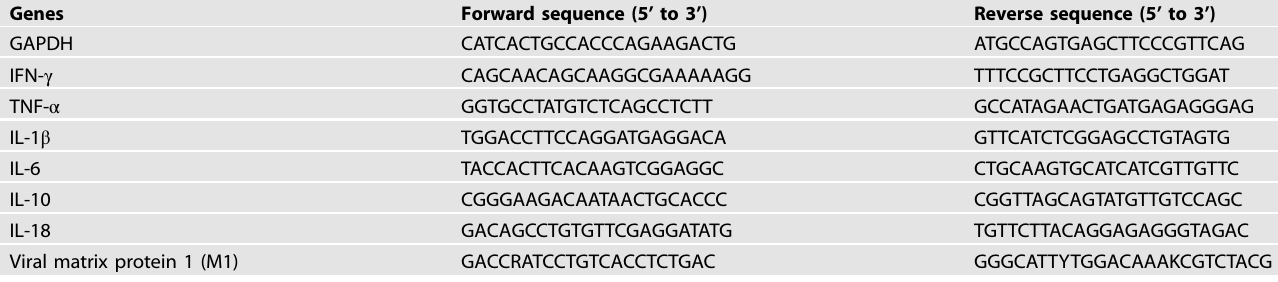
Table 2. Primers used for the ampli fi cation of mouse transcripts by real-time quantitative PCR. Genes Forward sequence (5 ’ to 3 ’